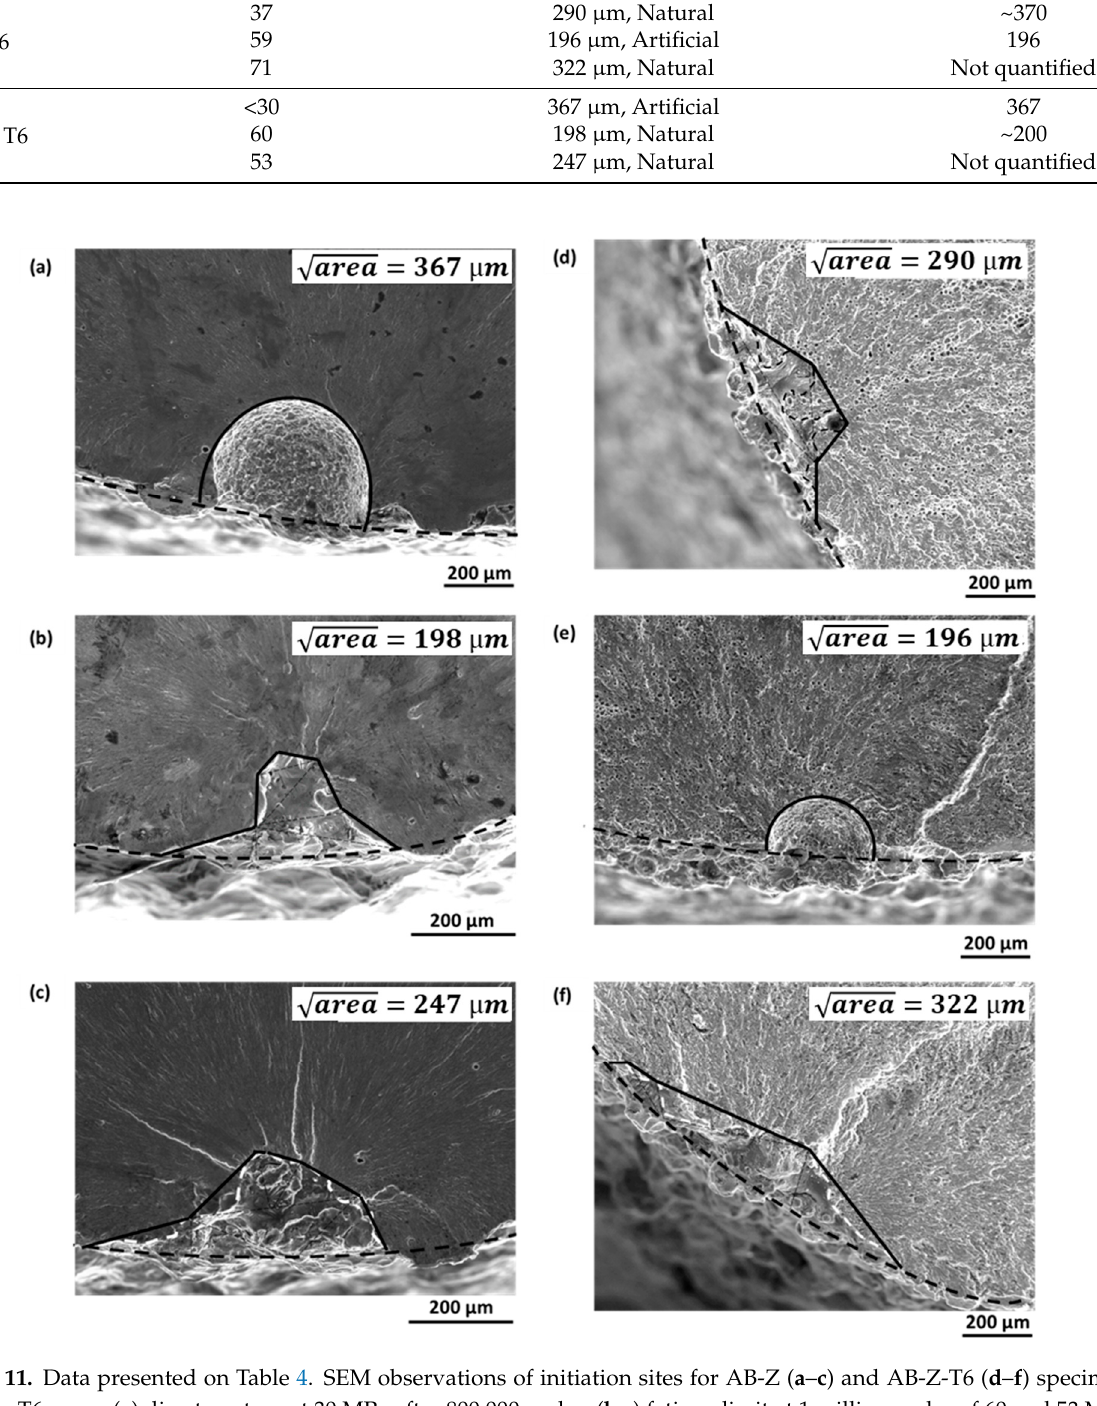
Table 4. Fatigue limits obtained on AB-Z with and without T6 heat treatment, containing different size of artificial defects. Heat Treatment